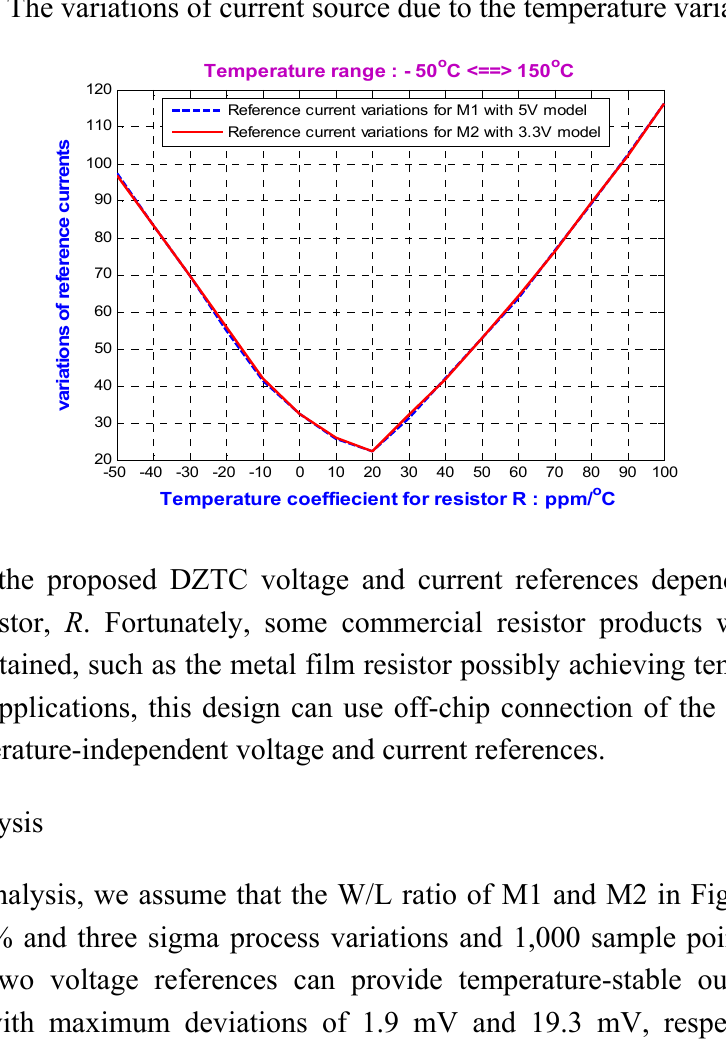
Figure 5. The variations of current source due to the temperature variation of R